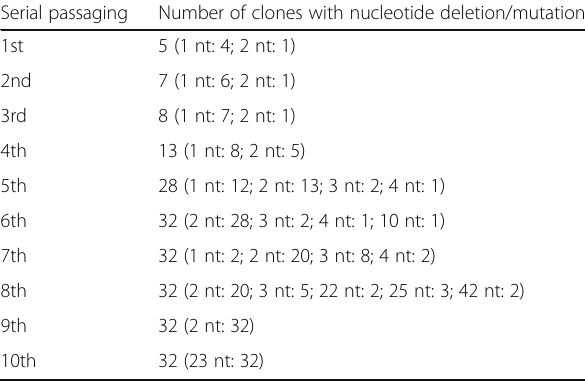
Table 1 Variation of clones with nucleotide deletion/mutation in sequence of the short non-coding sequence, UPD and TLS in TMV(24A+UPD) during serial passaging Serial passaging Number of clones with nucleotide